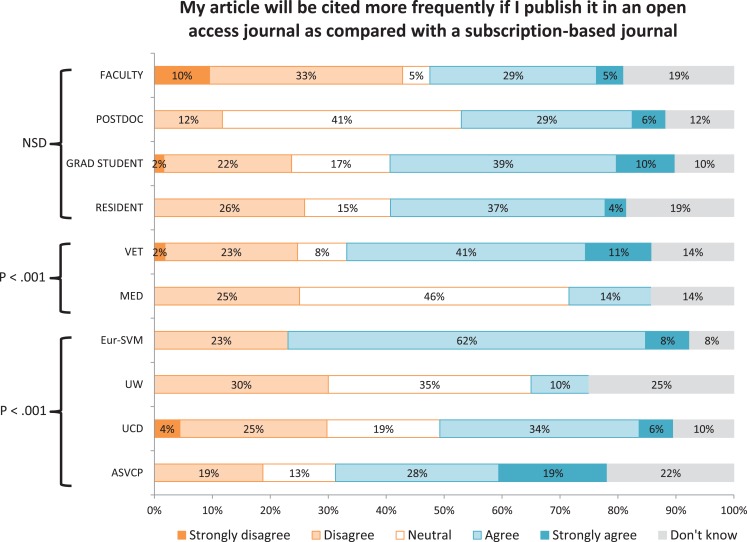
Differences in levels of agreement based on role, veterinary vs medical audience, and site for survey statement #3.